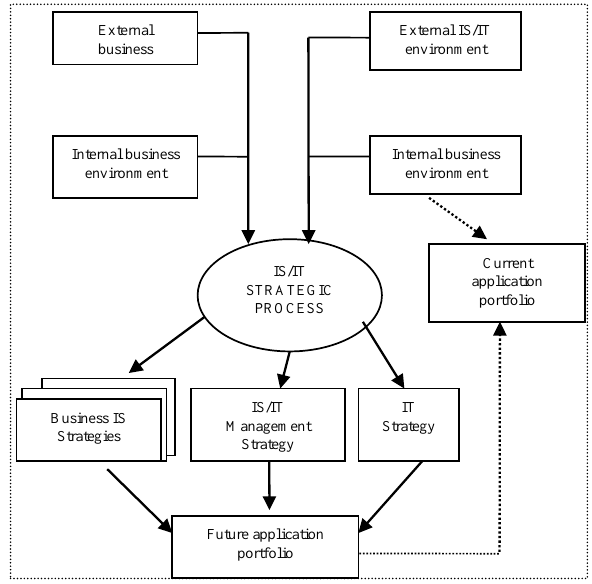
Figure 1: IS/IT Strategic Planning framework Ward and Peppard